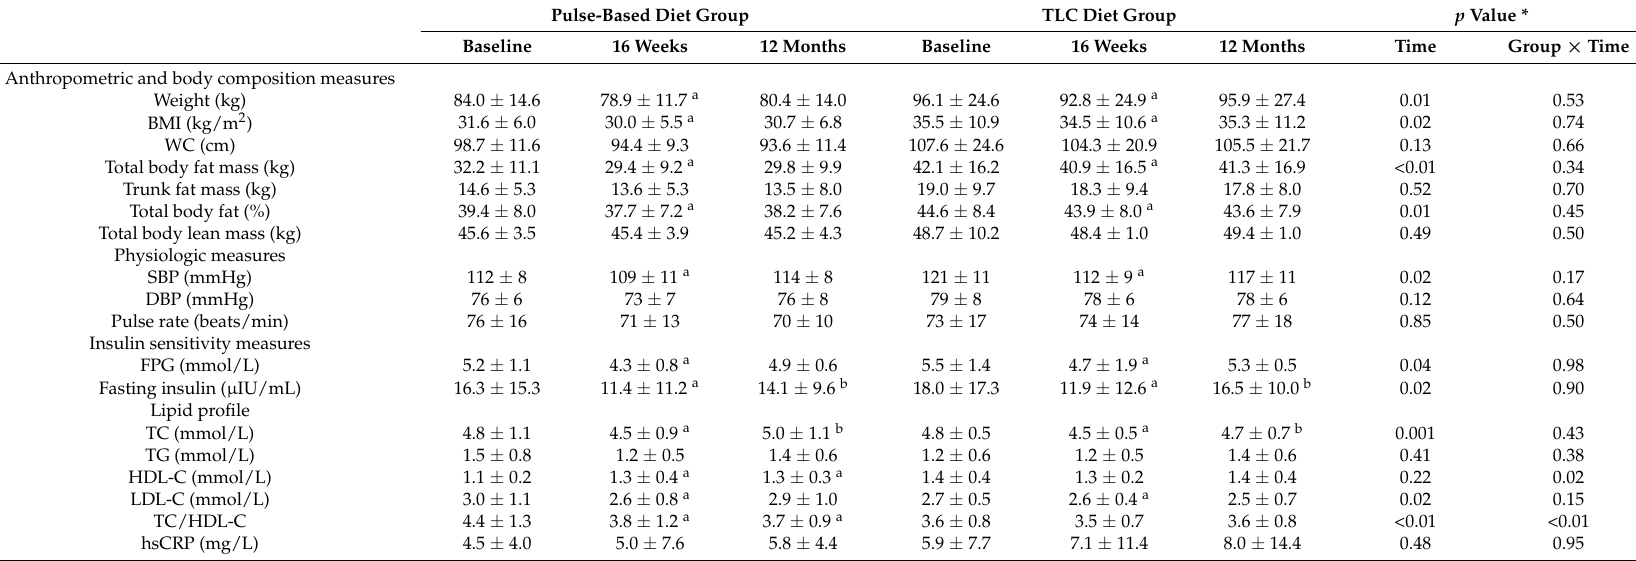
Table 5. Cardio-metabolic outcomes of women who completed the 12-month follow up phase of the study at baseline, 16 weeks, and 12 months post-intervention. Pulse-Based Diet Group TLC Diet Group p Value * Baseline 16 Weeks 12 Months Baseline 16 Weeks 12 Months Time Group × Time Anthropometric and body composition measures Weight (kg) 84.0 ±